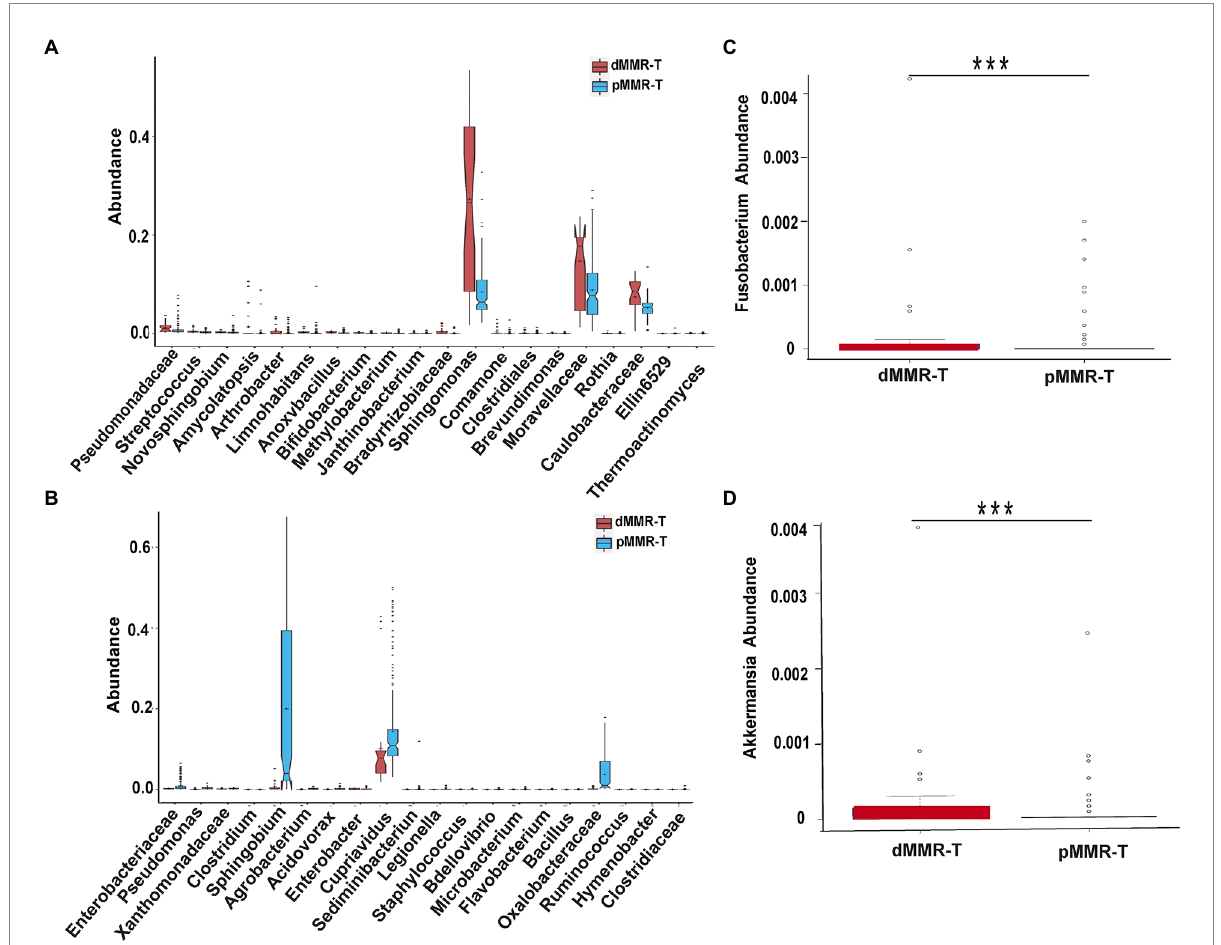
FIGURE 6 Different genera among the dMMR and pMMR groups. Increased genera (A) in dMMR-T group compared to pMMR-T group. Decreased genera (B) in dMMR-T group compared to pMMR-T group. The abundance of Fusobacterium was significantly different between dMMR-T and pMMR-T group (C) . The abundance of Akkermansia was significantly different between dMMR-T and pMMR-T group (D) . *** <